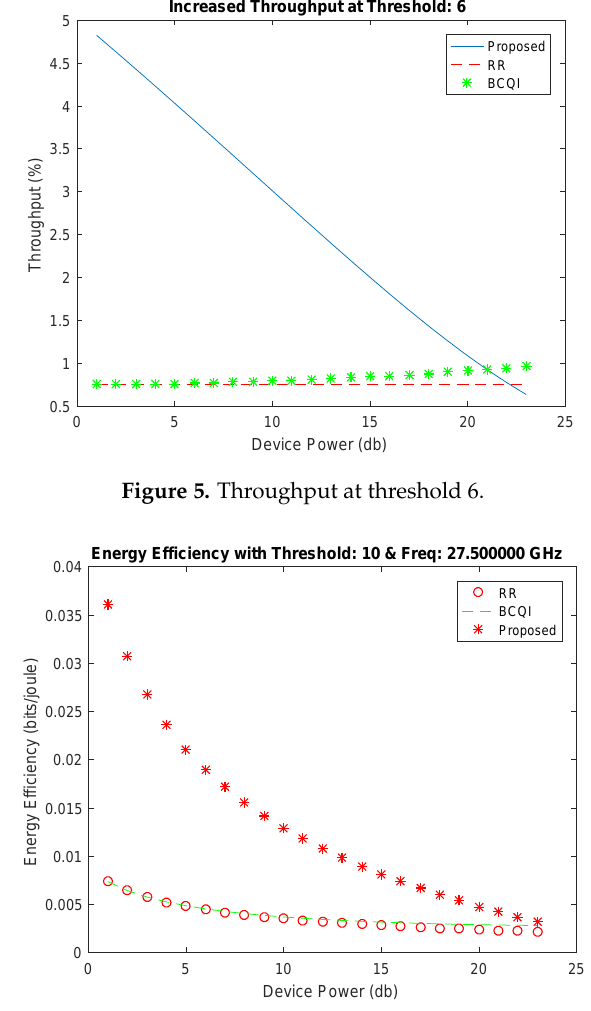
Figure 6. Energy efficiency achieved at threshold 10.